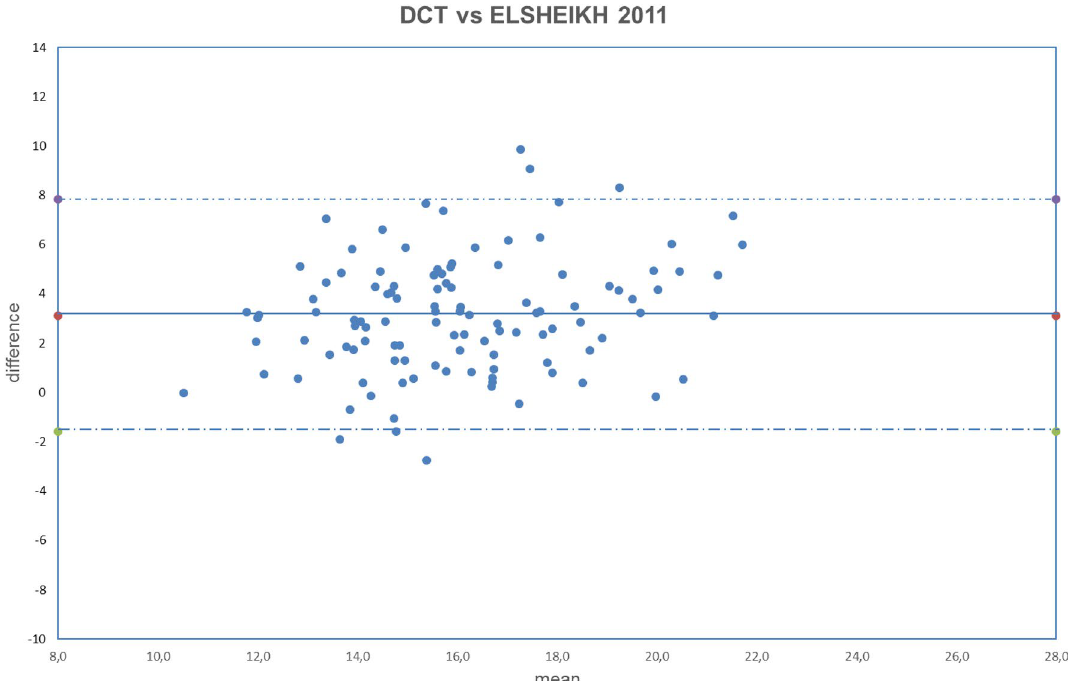
Figure 7. Bland–Altman plot between IOP measured with DCT and GAT corrected with Elsheikh2011 formula. Dashed line: mean difference. Dash-dotted lines: mean difference (3.13 mmHg) ± 2 standard deviation (2.36 mmHg) of the differences.